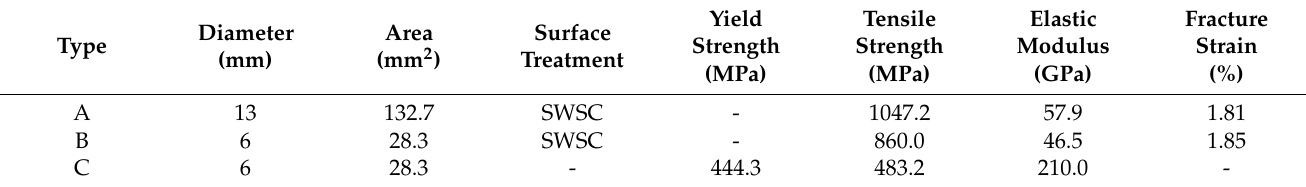
Table 1. Mechanical properties of reinforcing